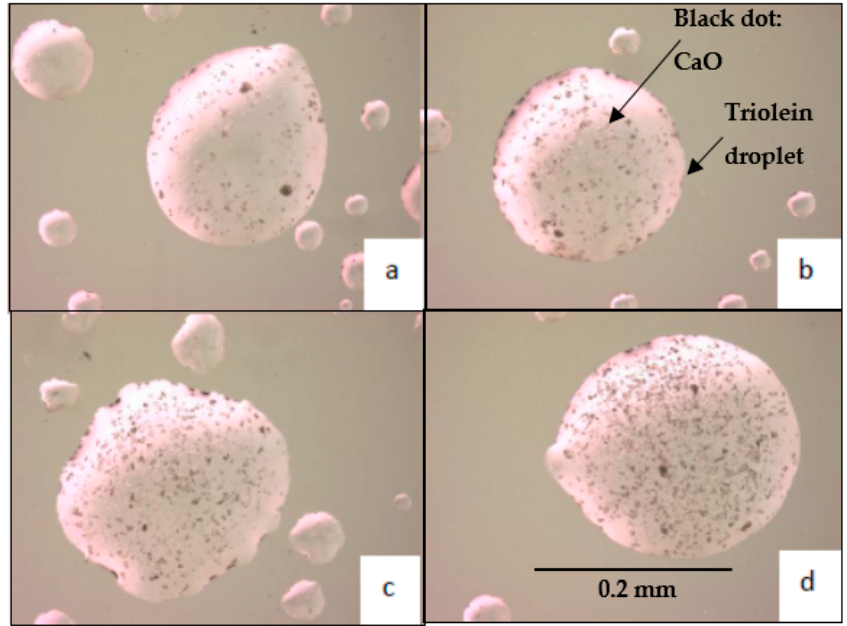
Figure 4. Pictures of droplets at CaO loadings of ( a ) 1 wt%, ( b ) 3 wt%, ( c ) 5 wt%, and ( d ) 7 wt%.